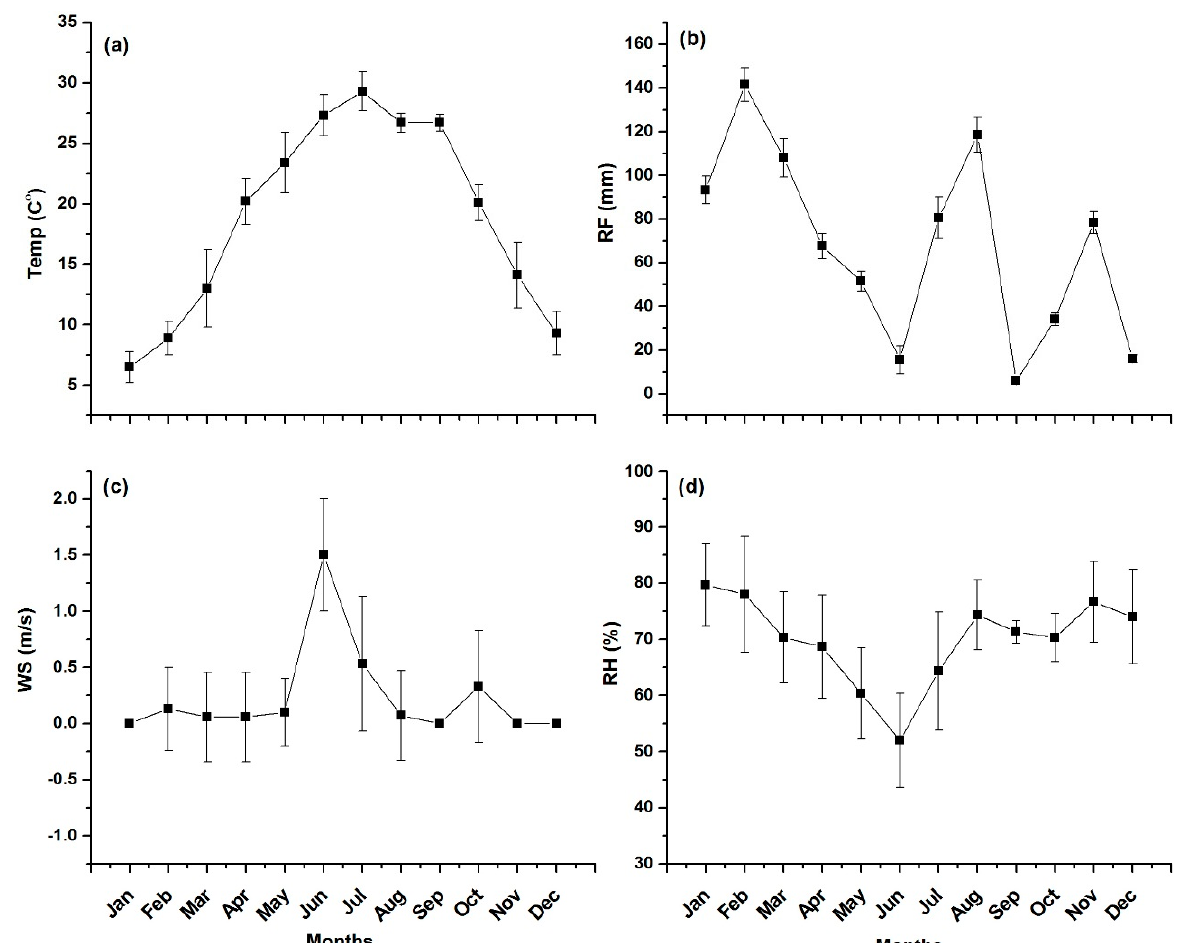
Figure 2. Meteorological conditions of Mingora city during the study period. The subfigures show the monthly variations in ( a ) Temperature ( b ) Rainfall ( c ) Wind speed and ( d ) Relative